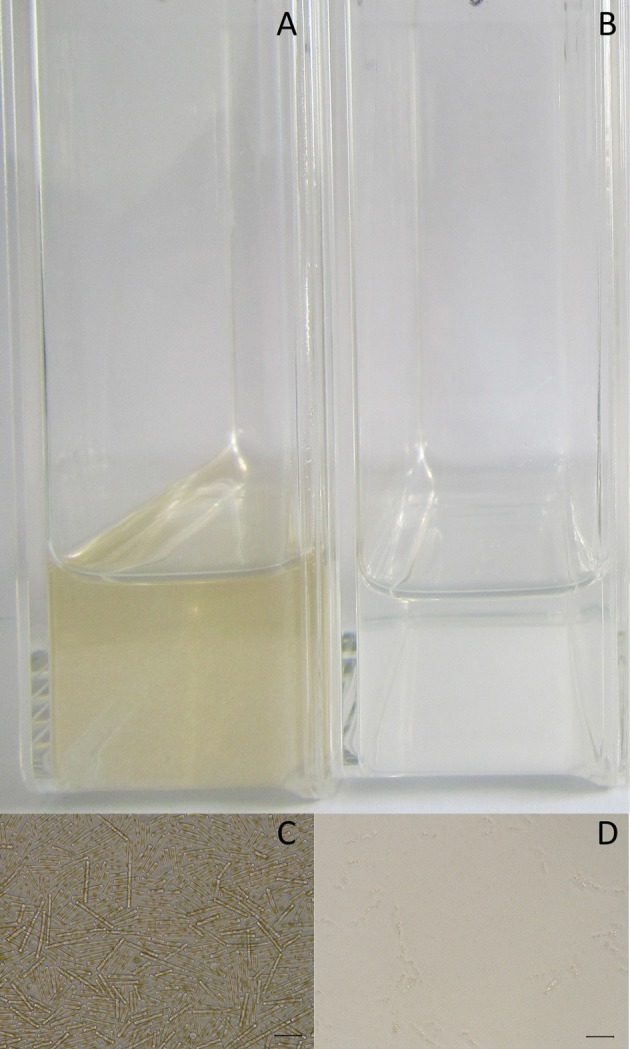
Aspect of healthy cultures of G. delicatula RCC3083 (A,C) and infected cultures by GdelRNAV-01 (B,D) that show disintegration of host cells. (A,B) Pictures of the flasks, (C,D) Light microscopy micrographs showing heathy cells with golden brown plastids (C) or cells totally degraded (D). All pictures were taken 14 days post-infection. Scale bars on pictures (C,D) 50 μm.